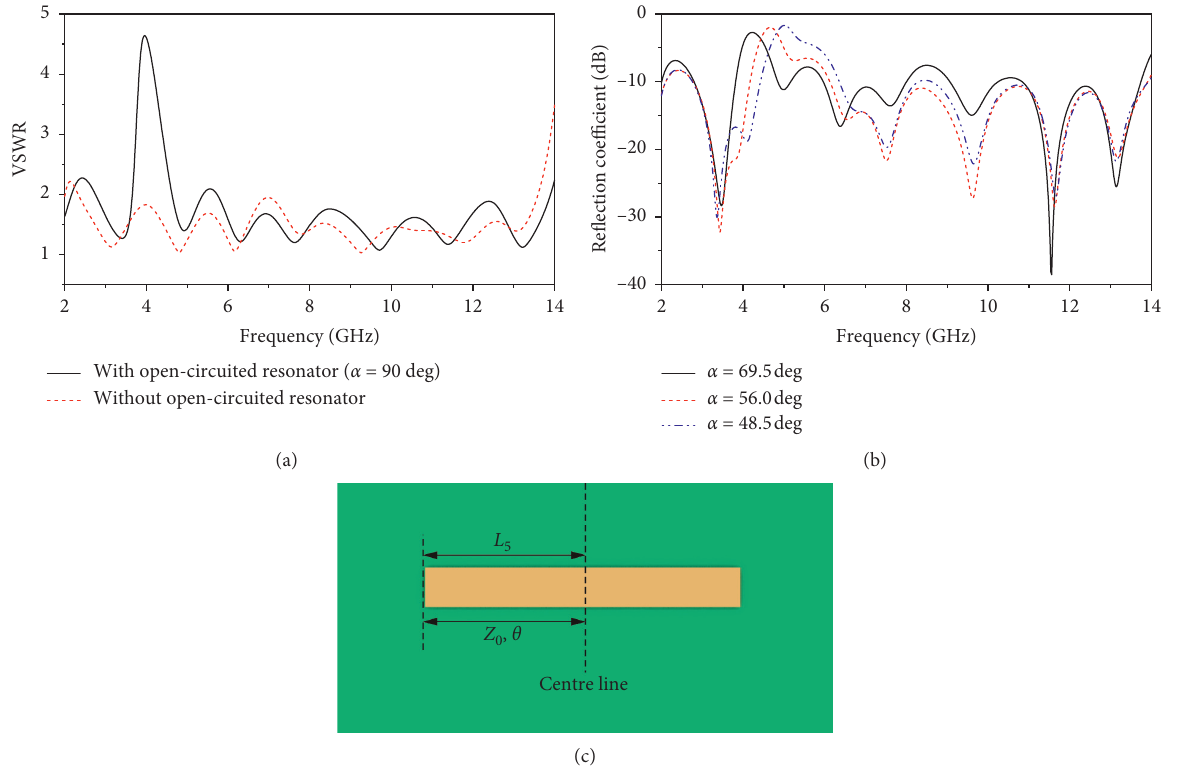
Figure 2: (a) VSWR of the antenna with the conventional Vivaldi antenna and modified patch. (b) Return loss varies according to the angle α. (c) The approximate equivalent circuit of the first